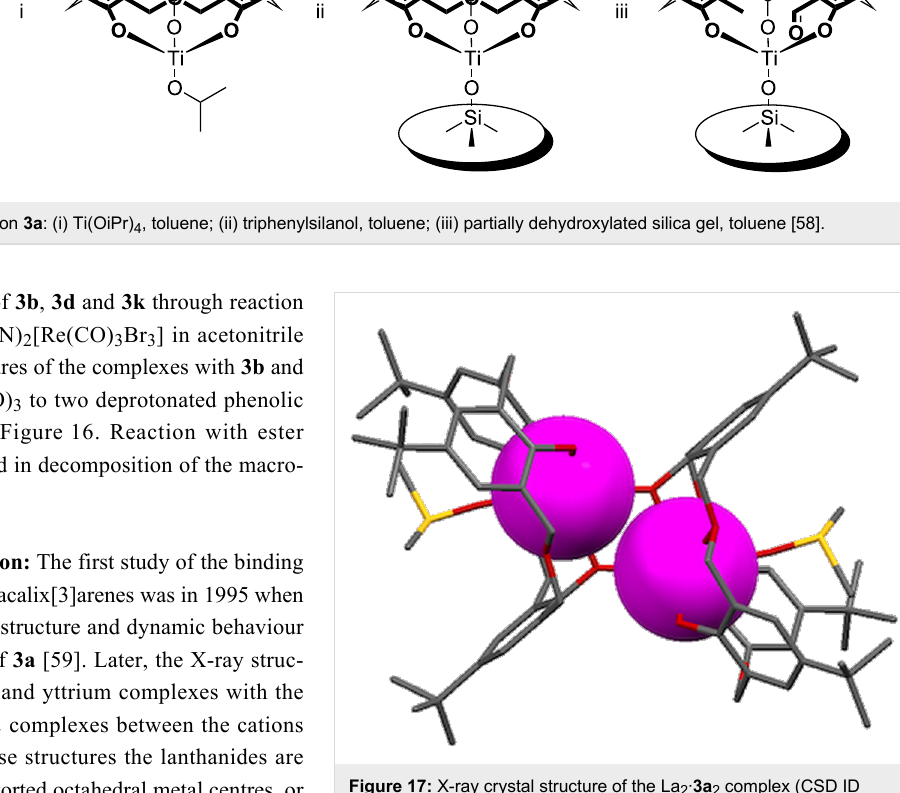
the strength of binding increased in the sequence Ca 2+ , Na + , Li + < Mg 2+ < La 3+ << Y 3+ < Lu 3+ << Sc 3+ . To reinforce this, the transporting ability of the oxacalixarenes was